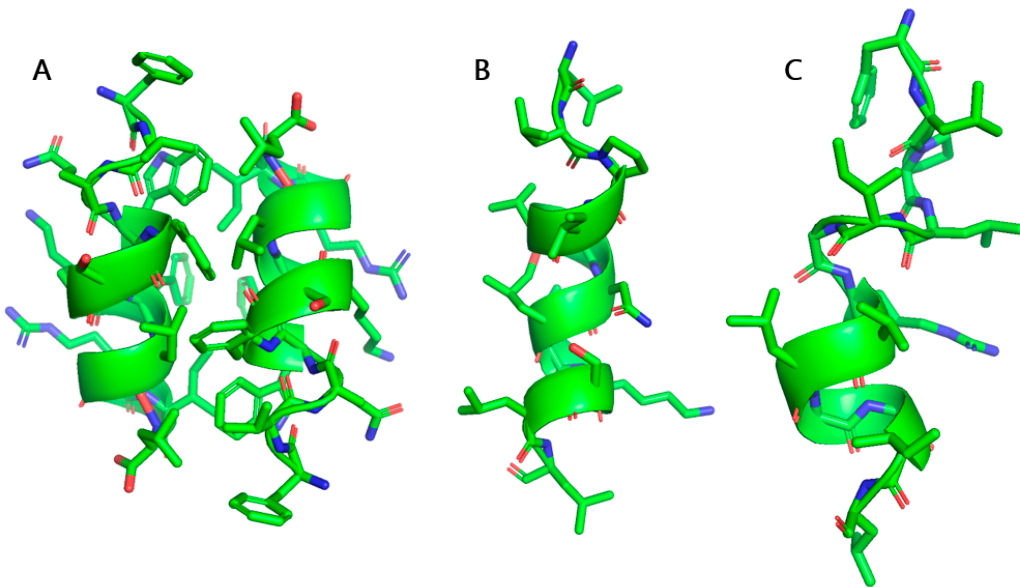
Figure 1. Structures of ( A ) the TL dimer; ( B ) TA; and, ( C ) TB in LPS. TL assumes an anti-parallel dimeric structure, stabilized by packing of aromatic and hydrophobic residues. The monomeric helical structures of TB and TA were obtained in the presence of TL peptide. The helical fold is represented by a ribbon. The figure was prepared using PyMOL molecular modelling software. The atomic coordinates of TL and TB were deposited in the BMRB data bank with accession numbers 21008 and 21005, respectively. The atomic coordinates of TA can be found in the Protein Data Bank with accession number 2MAA.